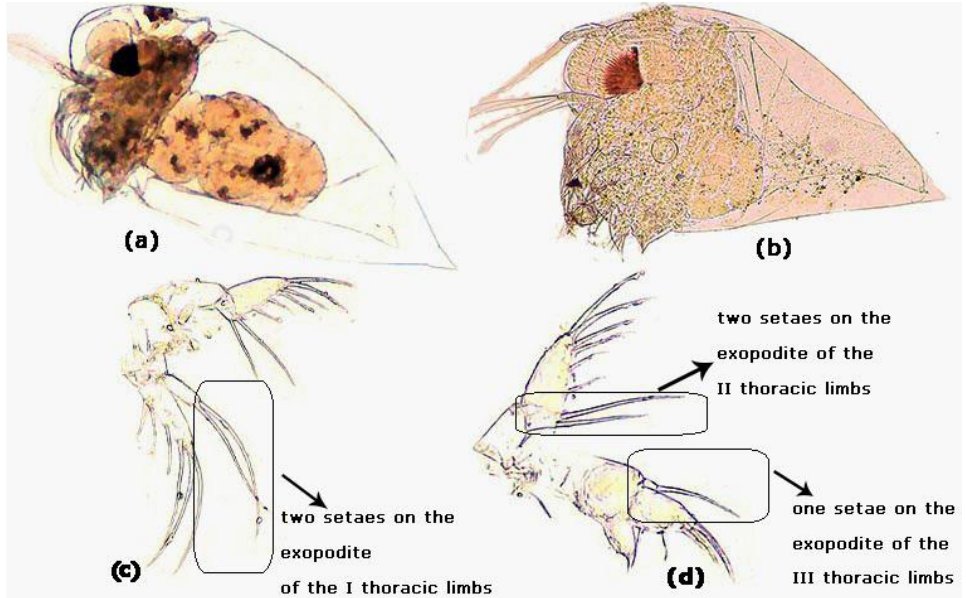
Figure 2. General form and I, II, III thoracic limbs of Evadne nordmanni. ( a ) general form of female; ( b ) general form of male; ( c ) I and II thoracic limbs; ( d ) II, III thoracic limbs.